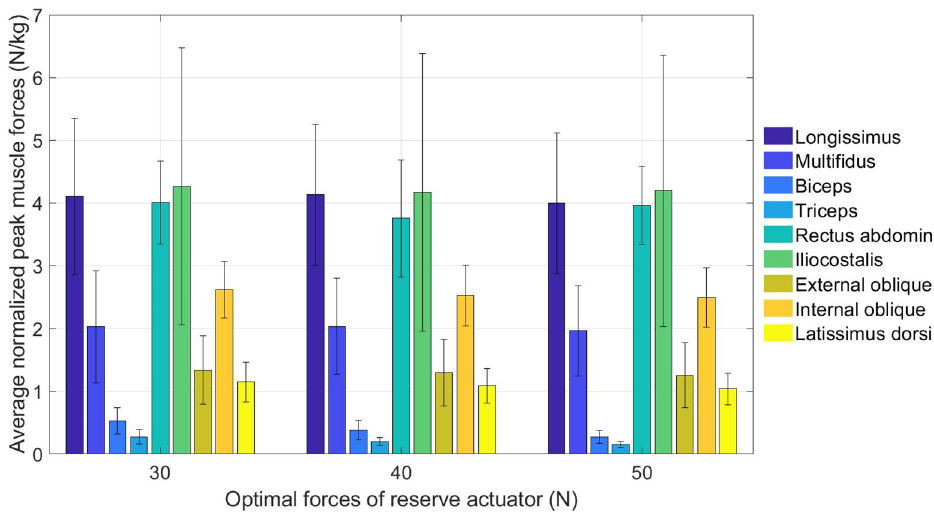
Figure 5. Average normalized peak muscle forces of the harvesters at different F RA – 30 N, 40 N and 50 N.